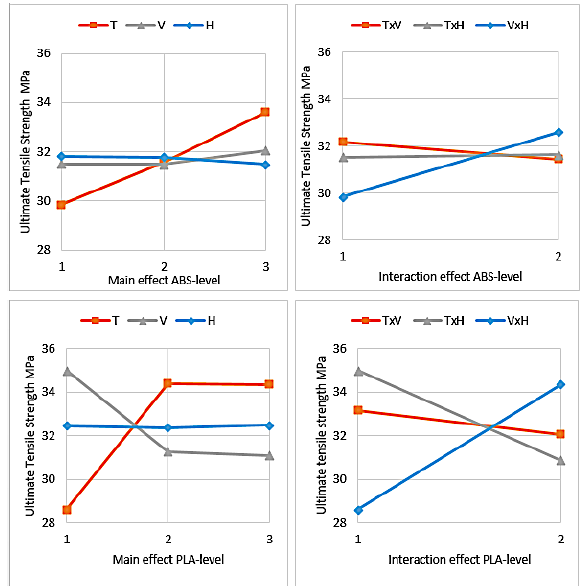
Figure 6. Main and interaction effect on ultimate tensile strength